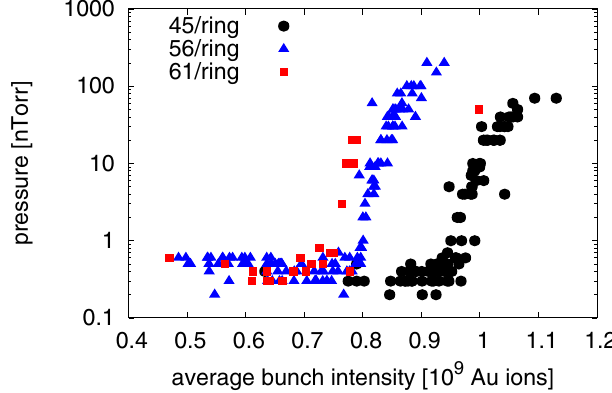
FIG. 3. (Color) Transition pressure rise in IR12 with Au beams as a function of the average bunch intensity. The bunch intensity is averaged over the Blue and Yellow ring intensities, and the values before and after transition. The data are further separated into ramps with 45, 56, and 61 bunches per ring. The dots show the maximum pressure at or shortly after transition [30].